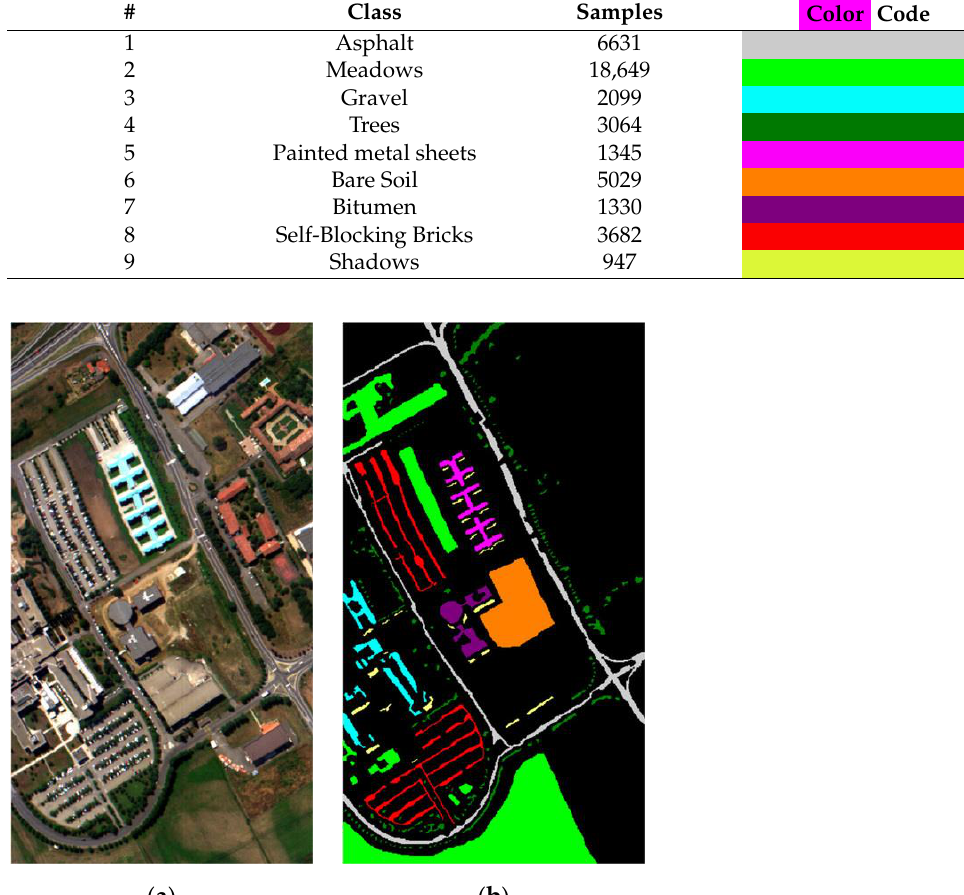
Figure 9. Pavia University scene dataset and the ground-truth map. ( a ) False color image; and ( b ) GT.